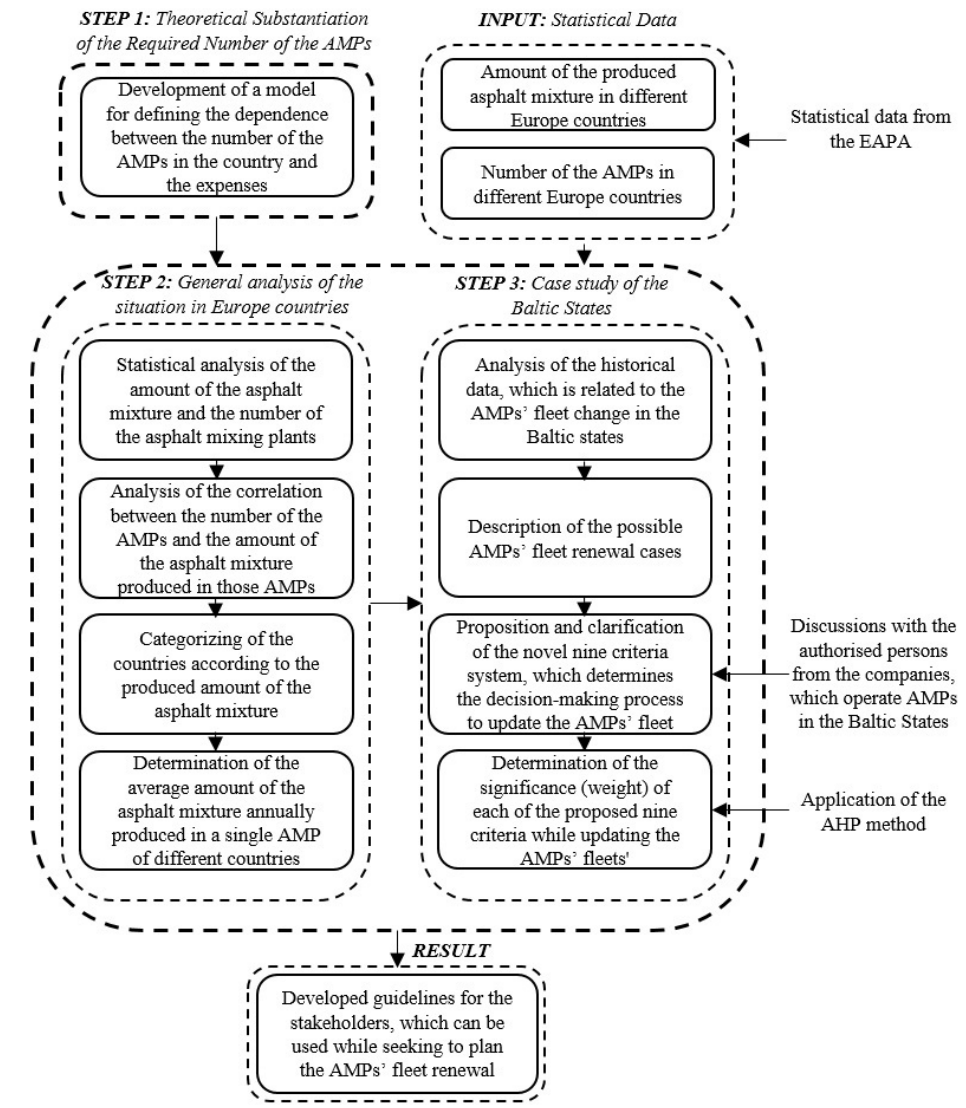
Figure 1. The research framework diagram of the study.